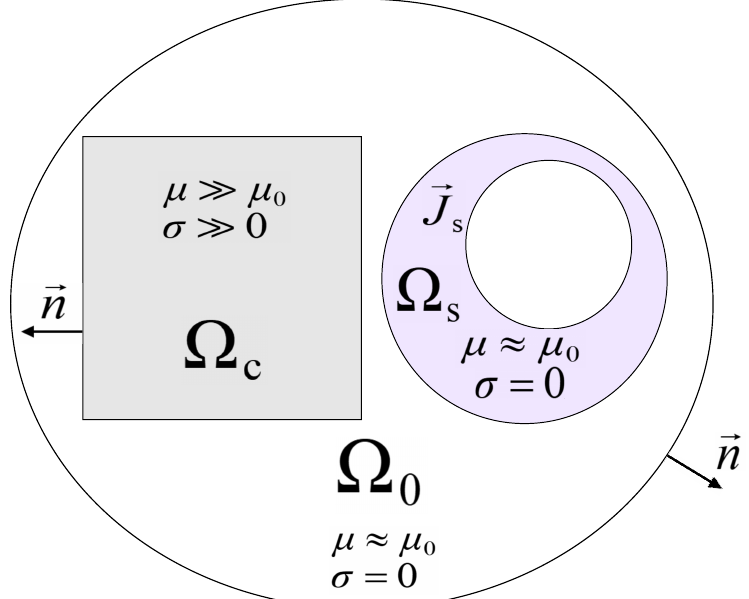
Figure 2. Definition of problem